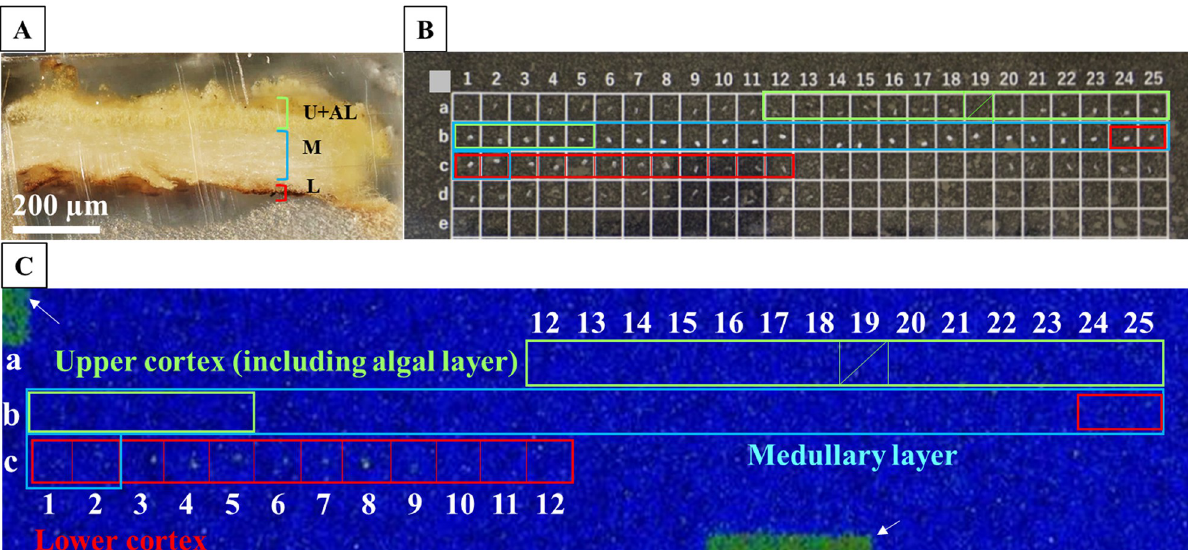
Fig 3. Radiocaesium distributions in the tissue sections of the FY2012PT thallus selected from fragment in Fig 2 showing the broad distributions. (A) Cross-sectional image of the FY2012PT lichen thallus tissue embedded in resin before microtome slicing. The thallus tissue was prepared from the broad distribution “a” of the FY2012PT sample in Figs 1 and 2. U+AL, upper cortex including the algal layer (these cannot be separated); M, medullary layer; L, lower cortex. (B) 5 μ m-thick tissue sections of lichen thallus on a square-shaped cell plate. The tissue sections were sliced from the surface side of the thallus tissue towards the lower cortex layer and laid on the cell plate in that order. “a-1” represents the 1st layer from the surface side, and “b-1” represents the 26th layer. Coloured frames are sections containing tissue. Green, aqua and red boxes indicate the areas corresponding to the upper cortex (including the algal layer), medullary layer and lower cortex, respectively. Overlapping boxes indicate that two layers were contained in the frames. The boxed areas without a coloured frame, i.e., from “a-1” to “a-11”, contained only resin and no tissue. A shaded area, i.e., “a-19”, represents missing a number. The “c-8” layer contains 2 sections. (C) Autoradiograph images of each tissue section on the cell plate. Block numbers are the same as described in (B). White arrows indicate marks used to determine the locations of the cell plate boxes. The sections were exposed for 14 days on the imaging plate (IP). Significant radiocaesium distributions were detected in sections “c-3” to “c-8” corresponding to the lower cortex. However, two tissue sections were observed in “c-8” cell (See S7